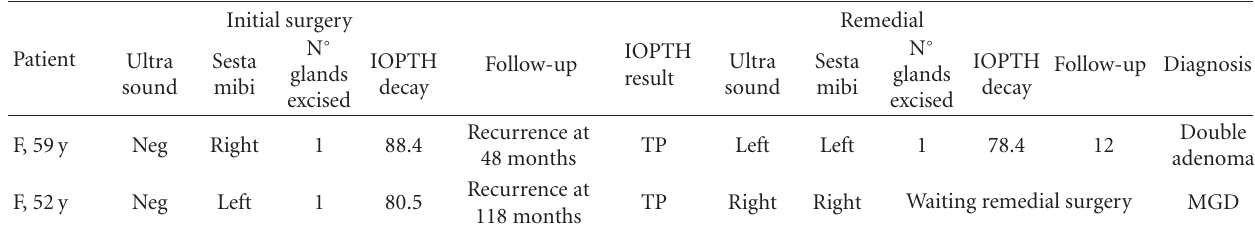
Table 3: Recurrence cases among the successful true-positive IOPTH patients.